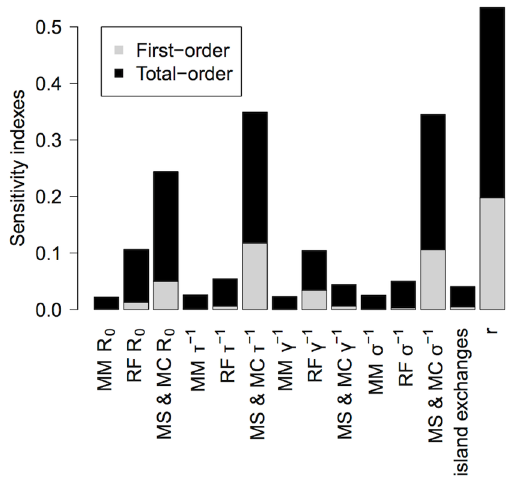
Figure 8. Estimated sensitivities of EBLV-1 persistence-index to the parameters in the model. The persistence index is highly sensitive to the reduction of contacts in the low-transmission period, and three M. schreibersii and M. capaccinii related parameters ( R 0 , and incubation- and immune-period durations). Virus persistence is also slightly sensitive to the R. ferrumequinum R 0 and the infectious period duration. The remaining parameters have total-order Sobol’ indexes , 0.1. Abbreviations are as given in the legend to Figure 3.